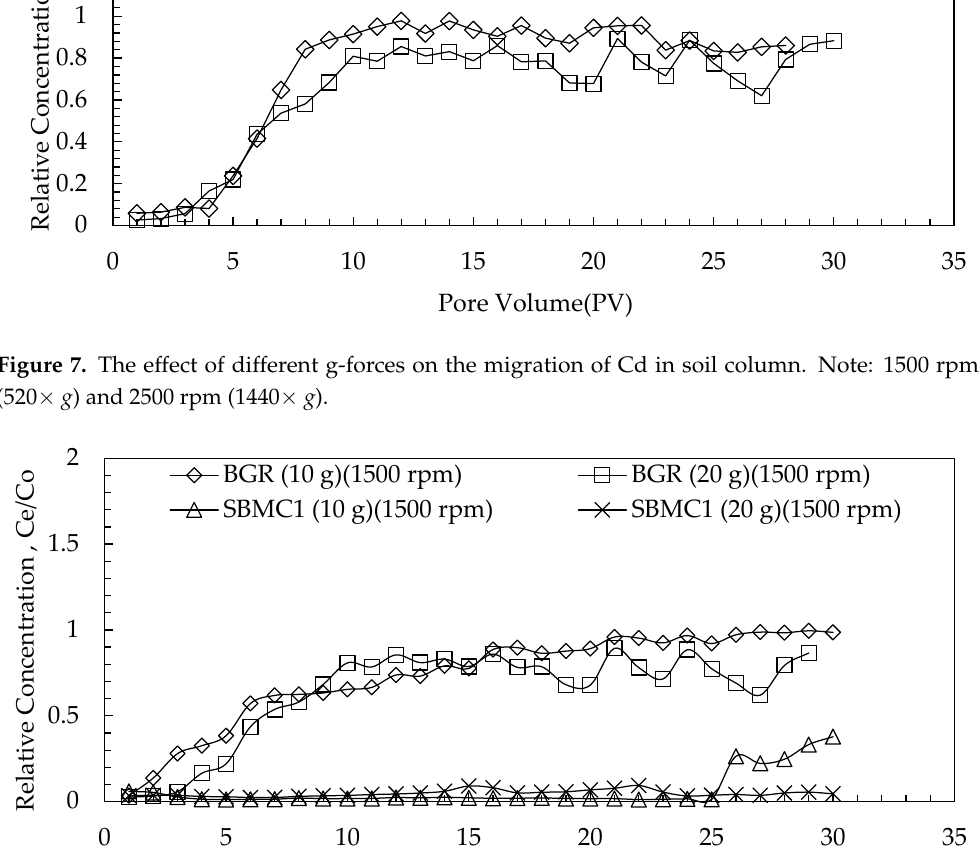
Figure 8. The effect of soil thickness on the migration of Cd. Note: 10 g (10 mm) and 20 g (20 mm).